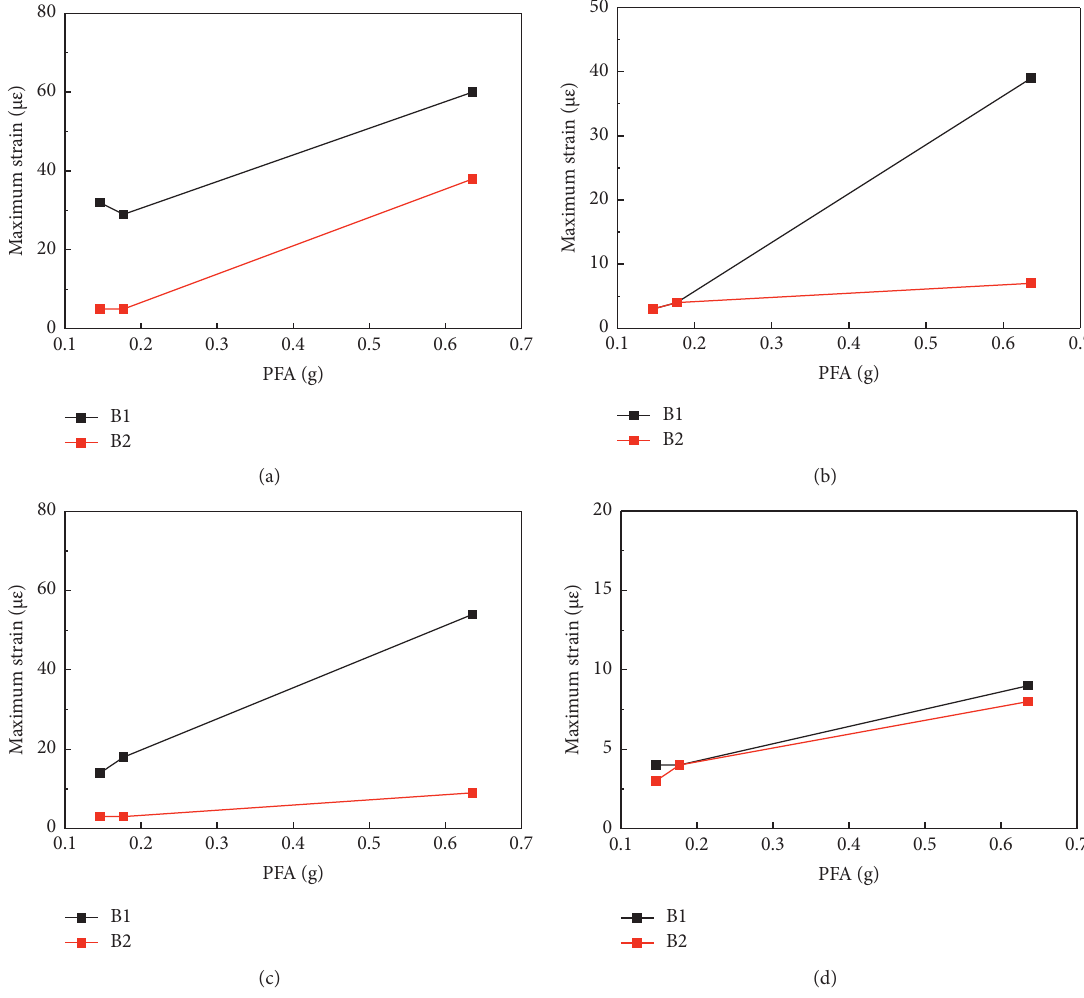
Figure 18: Maximum strain versus PFA relationship of ceiling components. (a) Threaded rod, (b) main tee, (c) cross tee, and (d) sub cross